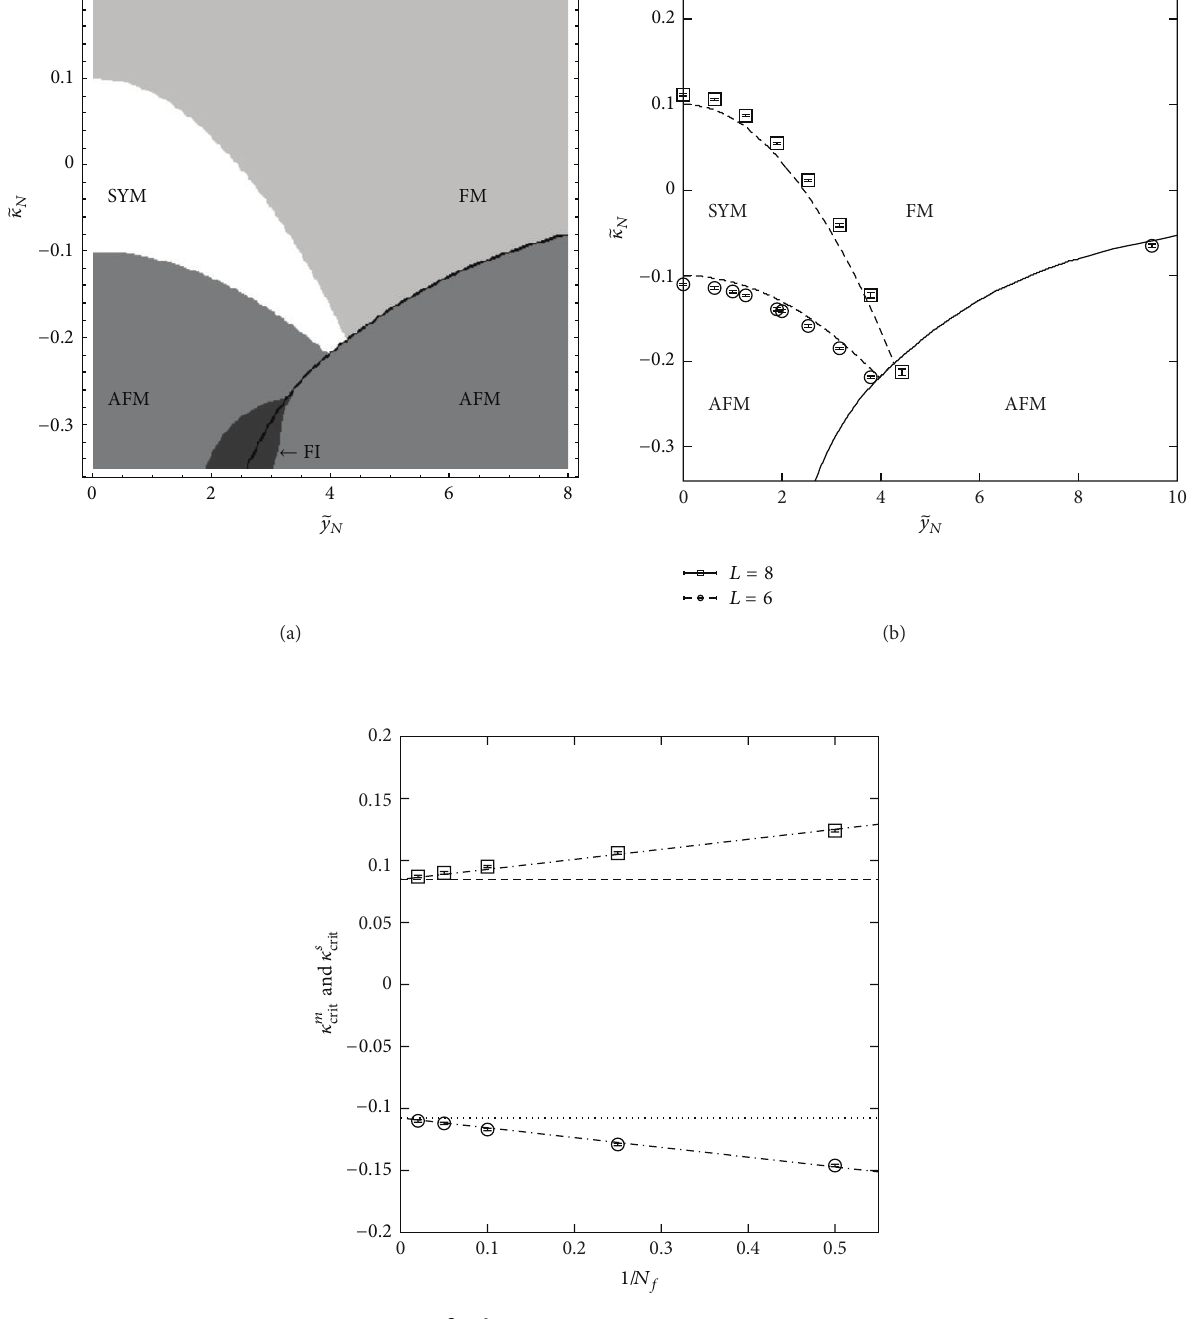
Figure 6: The phase structure analysis. (a) shows analytical predictions for the case of 𝐿 𝑠 = ∞ , 𝑁 𝑓 = ∞ and a first-order phase transition, while all other transitions are of second order. (b) demonstrates a numerical test of the transitions from the SYM to both FM and AFM phases with 𝑁 𝑓 = 10 . (c) displays the 𝑁 𝑓 dependence in the critical values of 𝜅 for the SYM-FM and SYM-AFM ̃ 𝜆 = 0.1 and ̃𝑦 = 1.0 . These critical 𝜅 values are denoted as 𝜅 𝑚 transitions, at 𝑁 𝑁 (b) and (c) come from direct numerical simulations on the indicated lattice